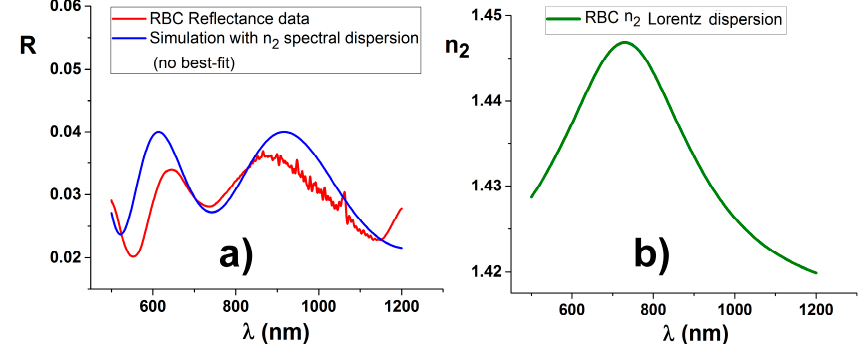
Figure 6. A reflectance curve, visible on the left ( a ), has been selected at the center of the RBC (red curve), marked in Figure 4. Solving procedures applied to the reflectance minima produce for n 2 the values of 1.41, 1.45, and 1.43, respectively, with an averaged value of 1.43, while the evaluated thickness d 2 is 750 nm ± 100 nm, both consistent with literature values. The overall shape is compatible with continuous n 2 dispersion, represented by a Lorentzian shaped curve centered at 730 nm and with a width of 400 nm, visible on the right ( b ). No numerical best fit is used, but only a few values are chosen after some attempts. The normalizing ratio produce marked noise in the region around 1 µm (CCD section). The second detector data are not shown because simulation is unreliable in that region, due to accumulation of errors for the procedure of merging the two detector spectral regions.